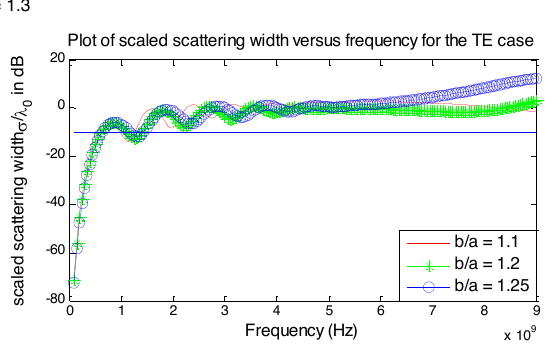
FIGURE 5. Normalized backscattering width (TE polarization) versus frequency of Rods only media coating for b/a = 1.1, 1.2 and 1.25 with fixed c/a =